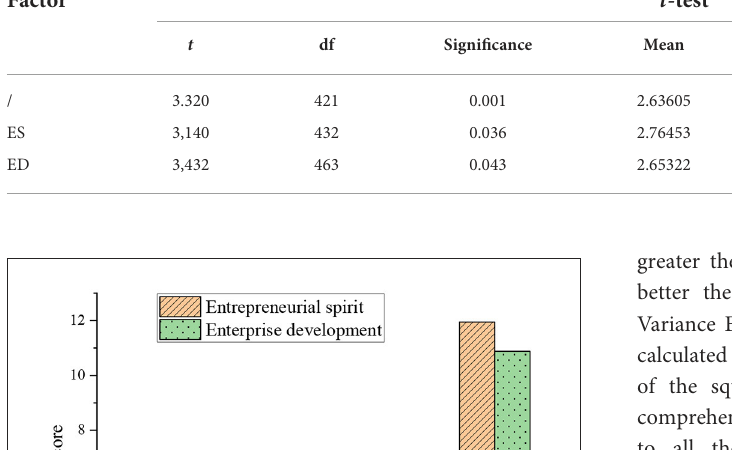
TABLE 2 Statistical table of independent sample t -test results of ES and ED. Factor